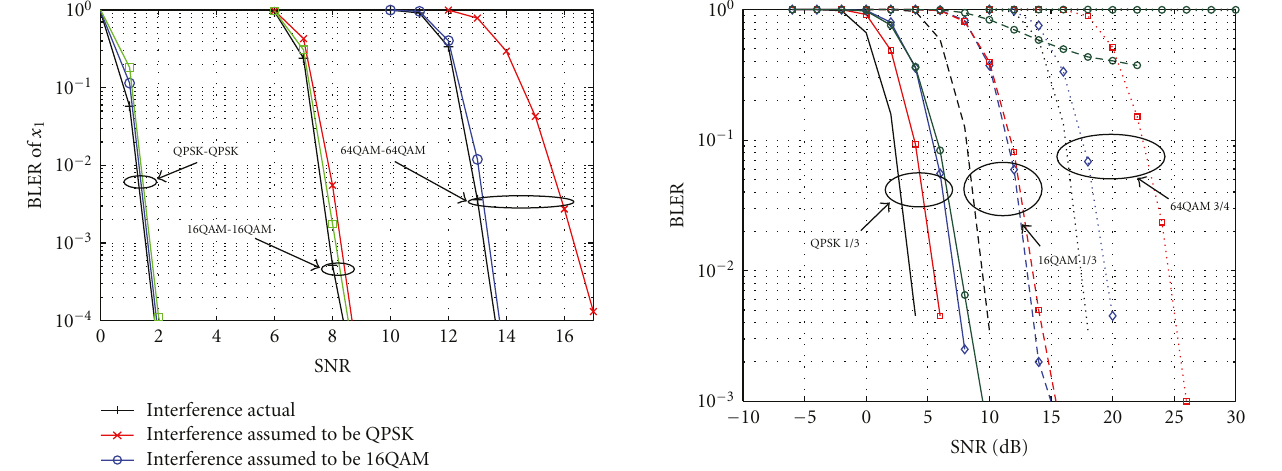
Figure 4: BLER versus SNR [dB] performance of MU-MIMO receivers for various modulation orders, urban micro (uncorre- lated), 30 km/h, no feedback delay, LS-channel estimation. Line legend: black solid: TM4, SU-MIMO, red (cid:2) : IRC, blue (cid:7) : max-log MAP, green ◦ :